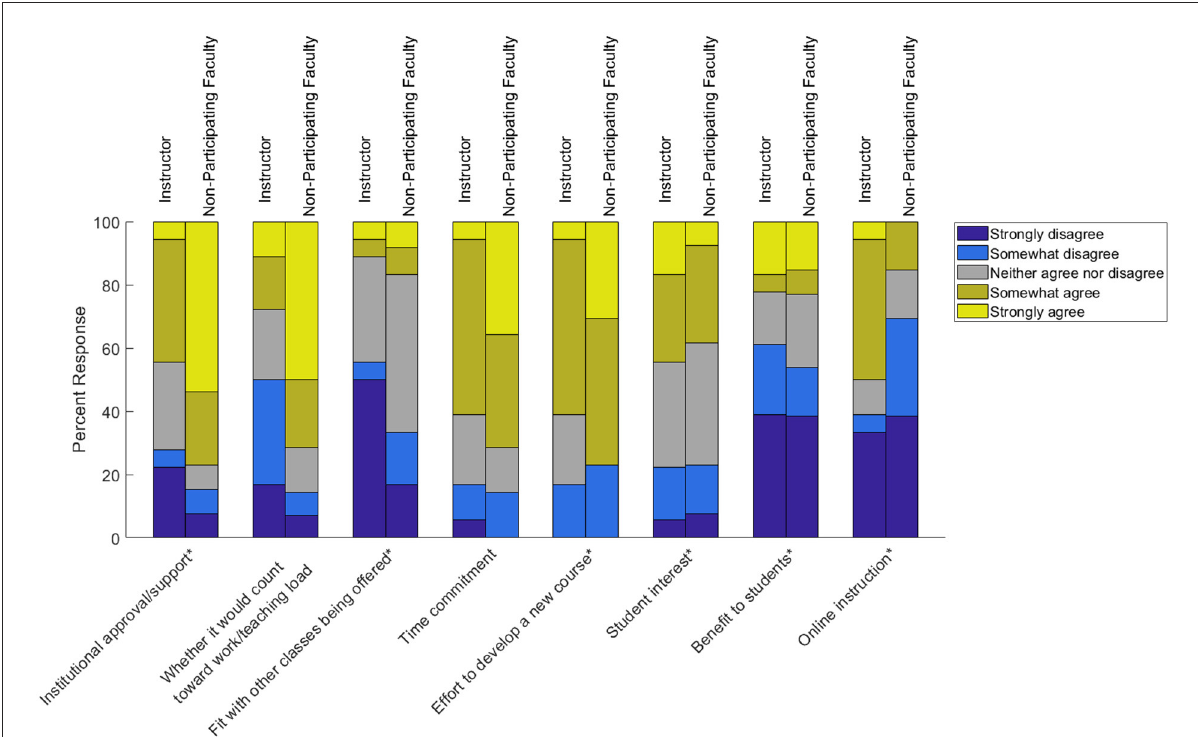
FIGURE5 Levels of concern about various factors prior to first involvement (for instructors) and when contemplating involvement (for non-participating faculty). The asterisk symbol indicates that there were one or more non-responses to the